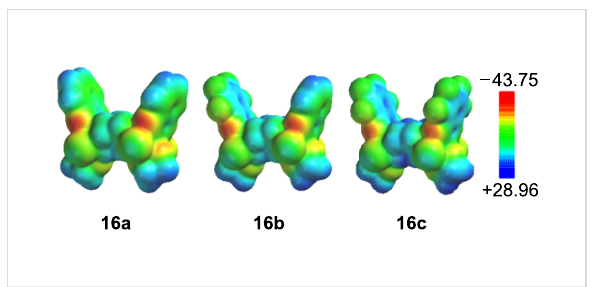
Figure 2: Electrostatic potential surfaces of 16a–c (Spartan 06 [41]: B3LYP/6-31G*//B3LYP/6-31G*; legend in kcal/mol).